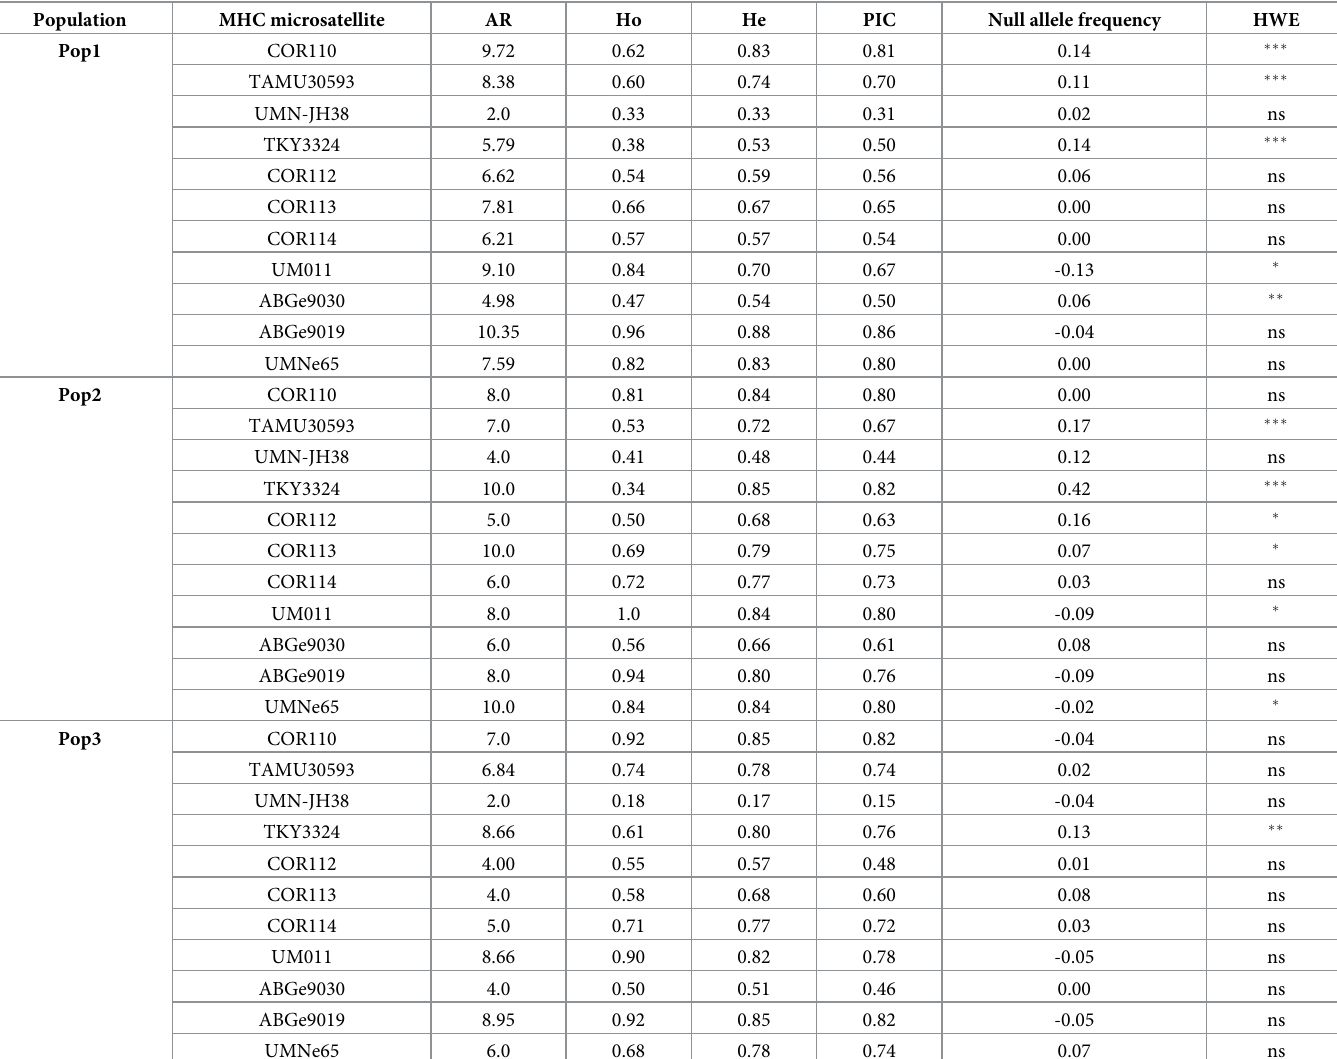
Table 2. MHC characteristics within populations. Population